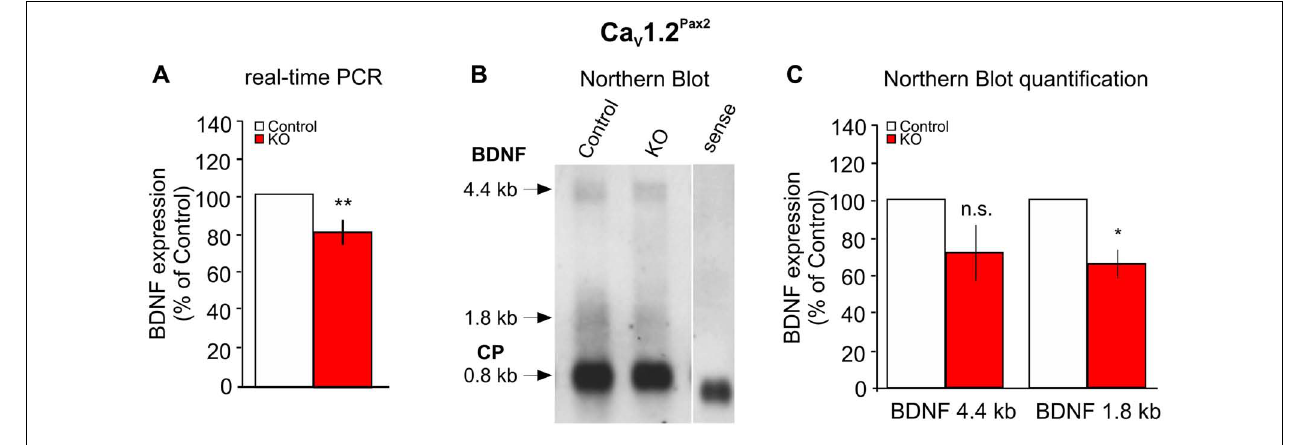
FIGURE 7 | Reduced expression of BDNF in the cochlea of Ca V 1.2 Pax2 KO mice. (A) Real-time PCR of BDNF exon IX mRNA in the cochlea of control (white bar) and Ca V 1.2 Pax2 KO mice (red bar), expressed as a percentage of the control set to 100%, shows a significant reduction of the mRNA level in the KO mice (Ca V 1.2 Pax2 control: n = 11 mice; Ca V 1.2 Pax2 KO: n = 10 mice, two-sided Student’s t -test: p = 0.006). (B) Northern blot of control and Ca V 1.2 Pax2 KO mice cochlea showing the two BDNF